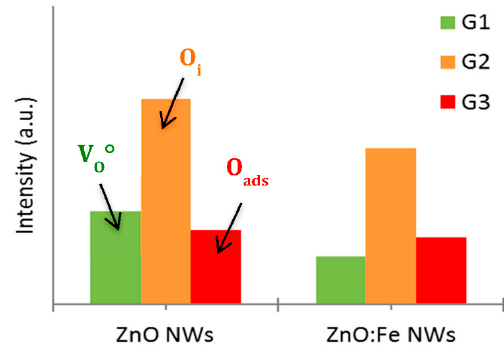
Figure 9. Intensity evolution of the various defect emissions in undoped and Fe-doped ZnO NWs.